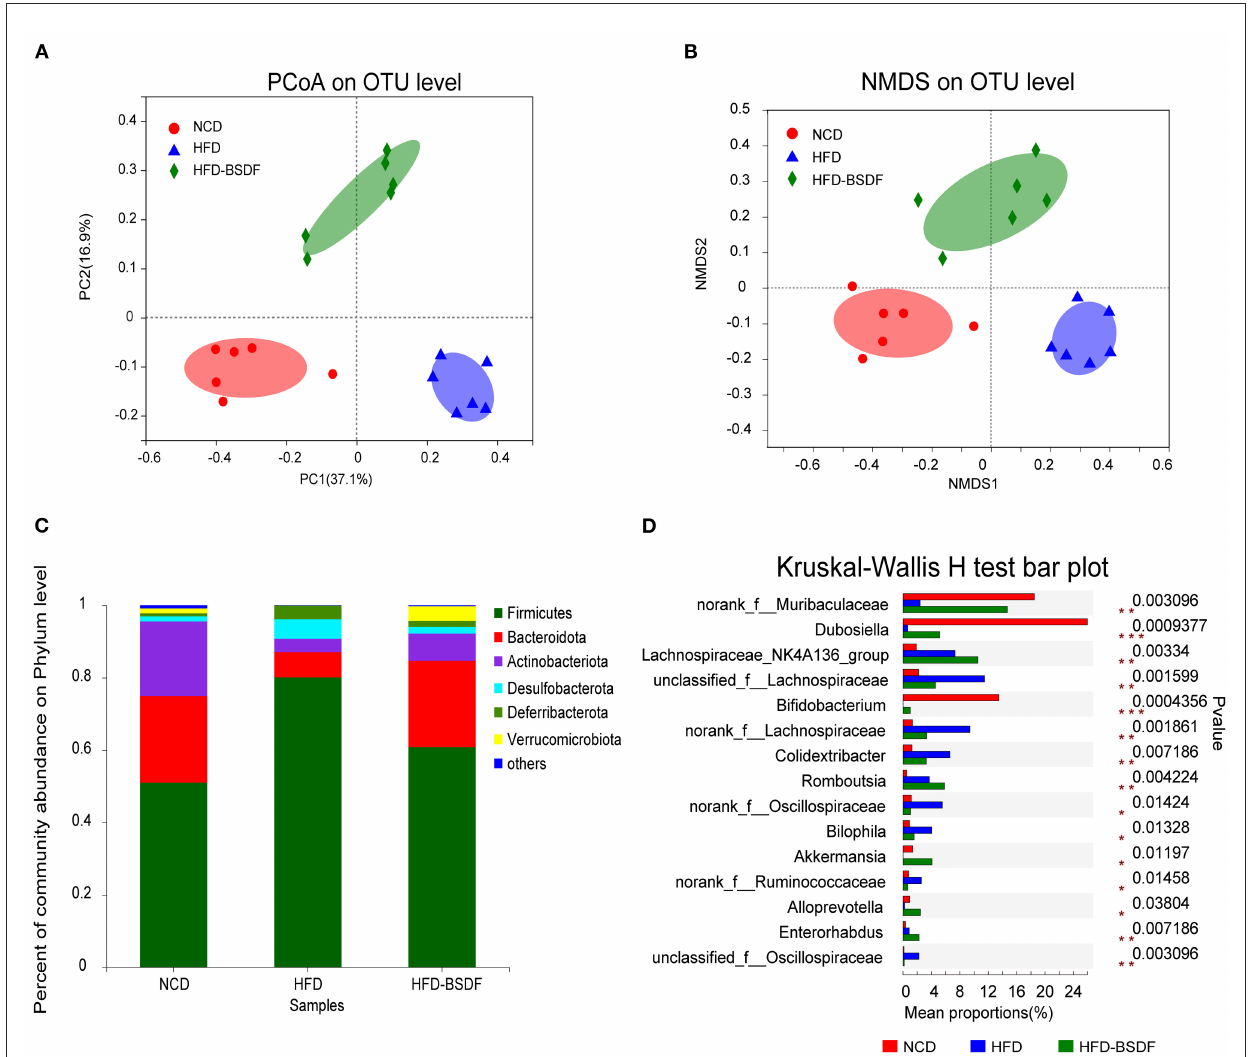
FIGURE4 BSDF attenuated gut microbiota dysbiosis in HFD-fed mice. (A, B) PCoA and NMDS score plot based on Bray–Curtis. (C, D) The abundances of the gut microbiota at the phylum level, and the genus level. n = 6, per group. NCD, normal control diet; HFD, high-fat diet; HFD-BSDF, high-fat diet supplemented with 6% BSDF freeze-dried